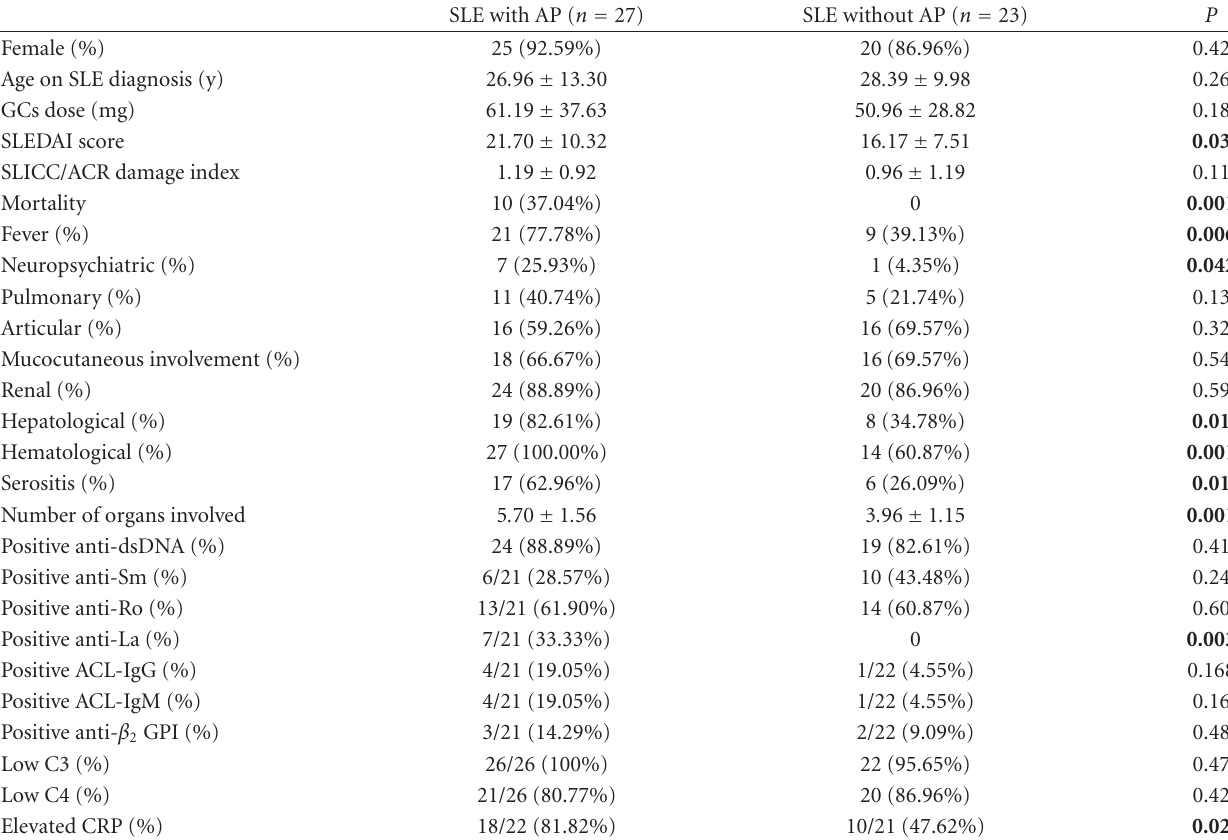
Table 2: Comparison of demographic and clinical features in SLE patients with and without